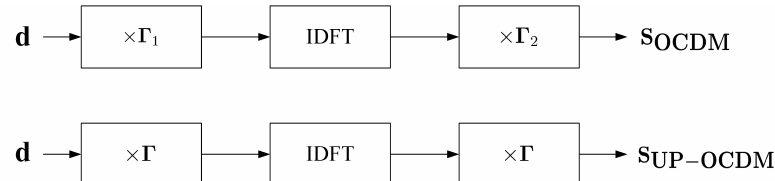
Figure 1. Modulation procedures of the orthogonal chirp division multiplexing (OCDM) (upper) and uniform phase-OCDM (UP-OCDM)